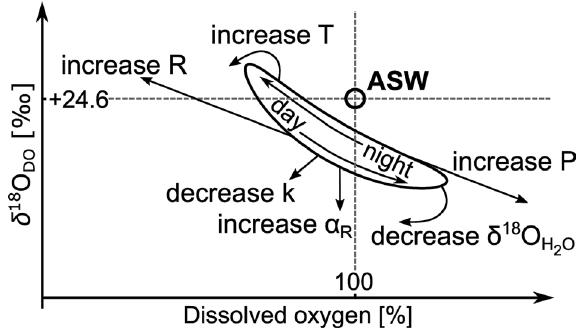
Figure 1. Schematic illustration of effects on dissolved oxygen (DO) and its stable DO isotopes ( δ 18 O DO ) by photosynthesis (P) and ecosystem respiration (R) with the respiration isotope fractionation factor (α R ), the gas exchange coefficient (k), stable water isotopes ( δ 18 O H2O ) and water temperature (T) after Venkiteswaran et al. 27 . Horizontal and vertical dashed lines and the empty circle represent air saturated water (ASW) with DO saturation at 100% and δ 18 O DO at + 24.6‰. The oval line represents a typical hysteresis curve during the course of a diel